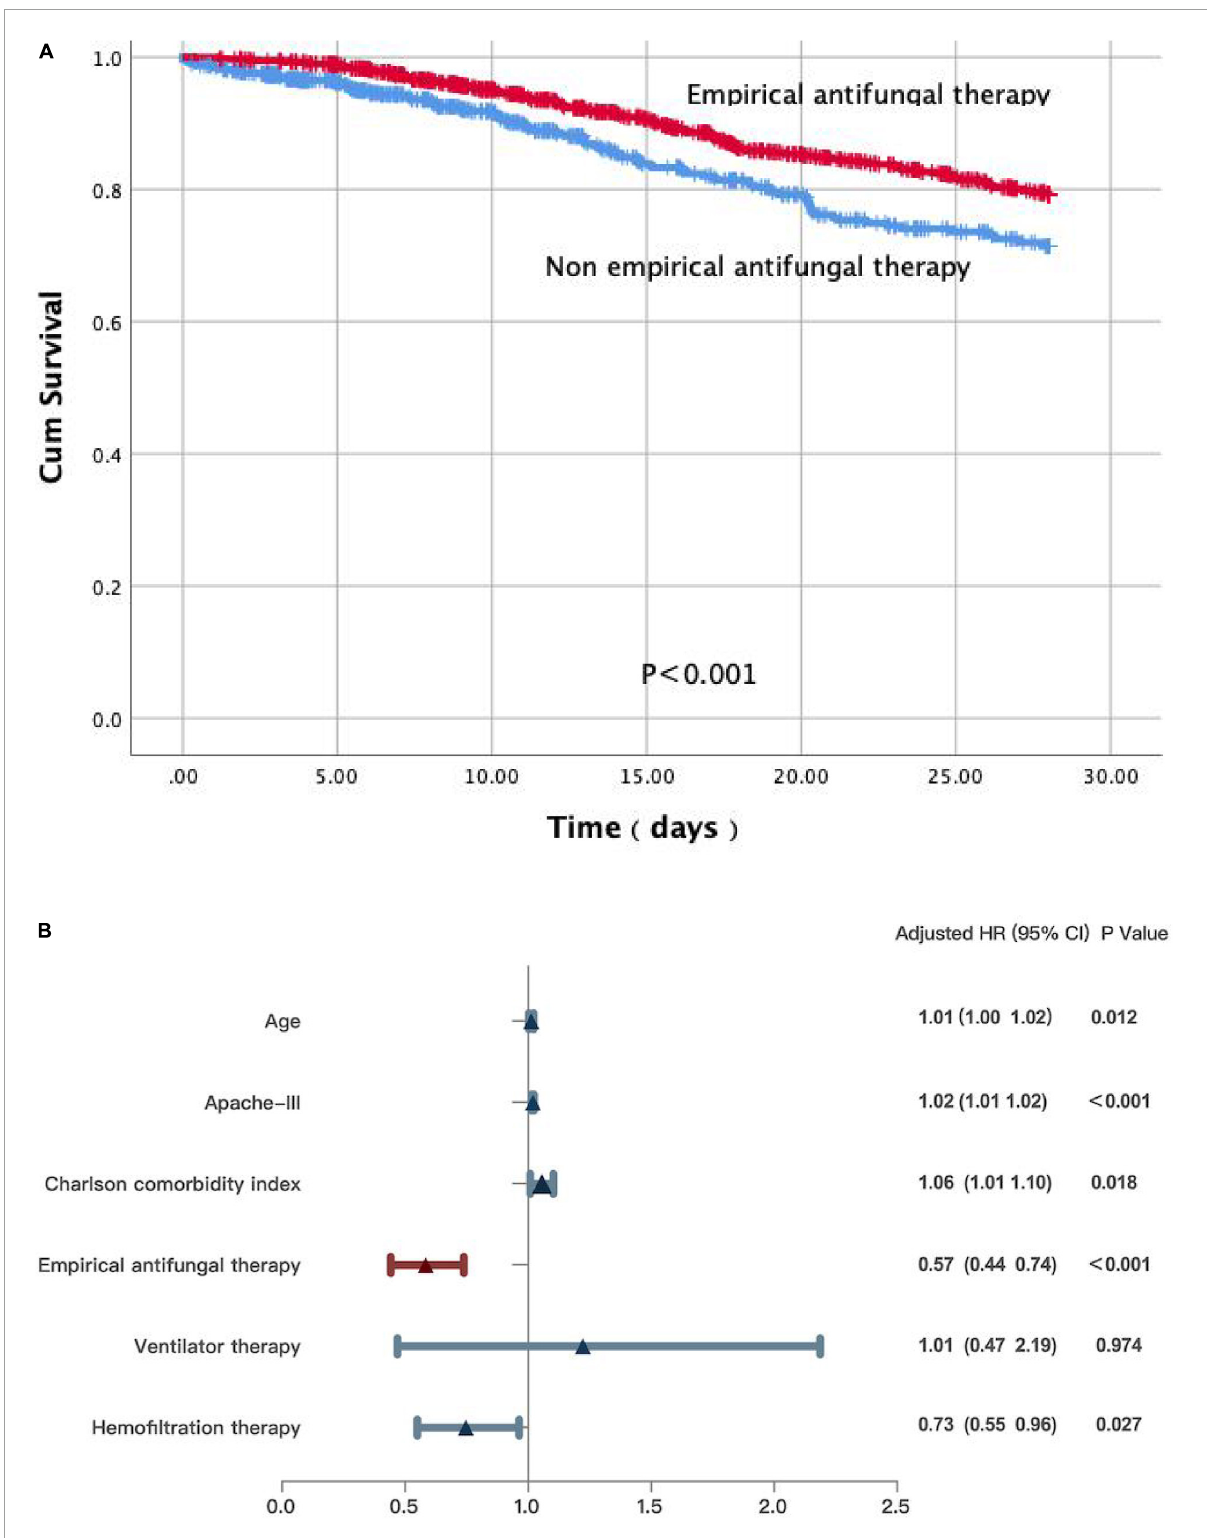
FIGURE2 (A) A Kaplan-Meier survival analysis and a log-rank test on patients with IFI in ICU. (B) Multivariate Cox regression analyses for patients with IFI in